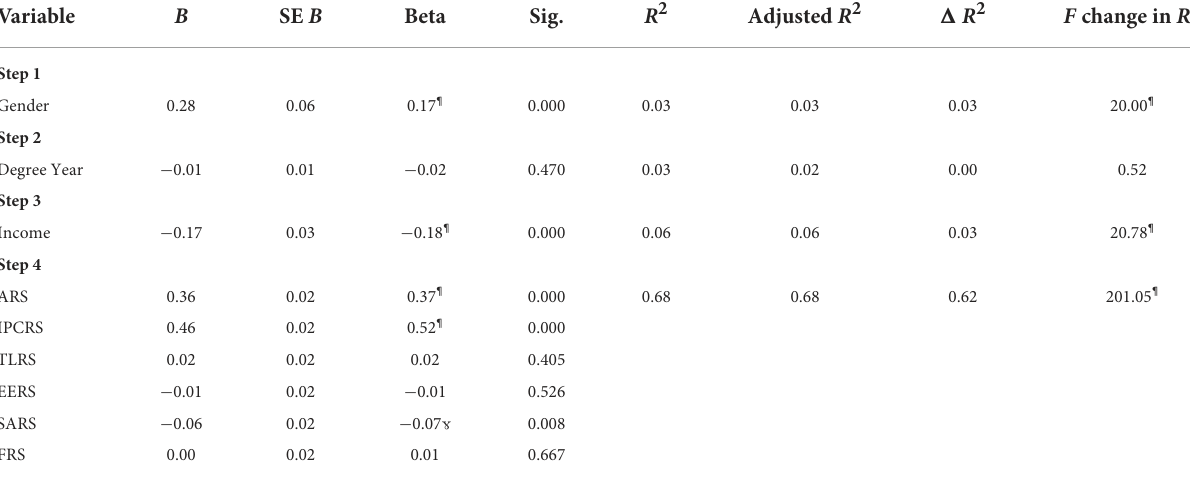
TABLE 7 Hierarchical regression of independent variables on overall stress among veterinary students.